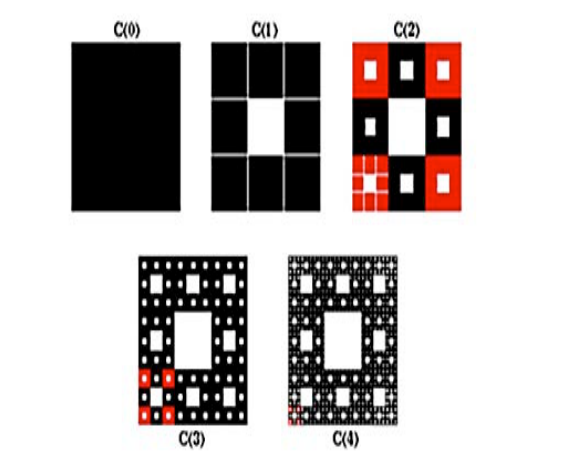
Figure 1: The first five iterations of the Sierpinski carpet [19].